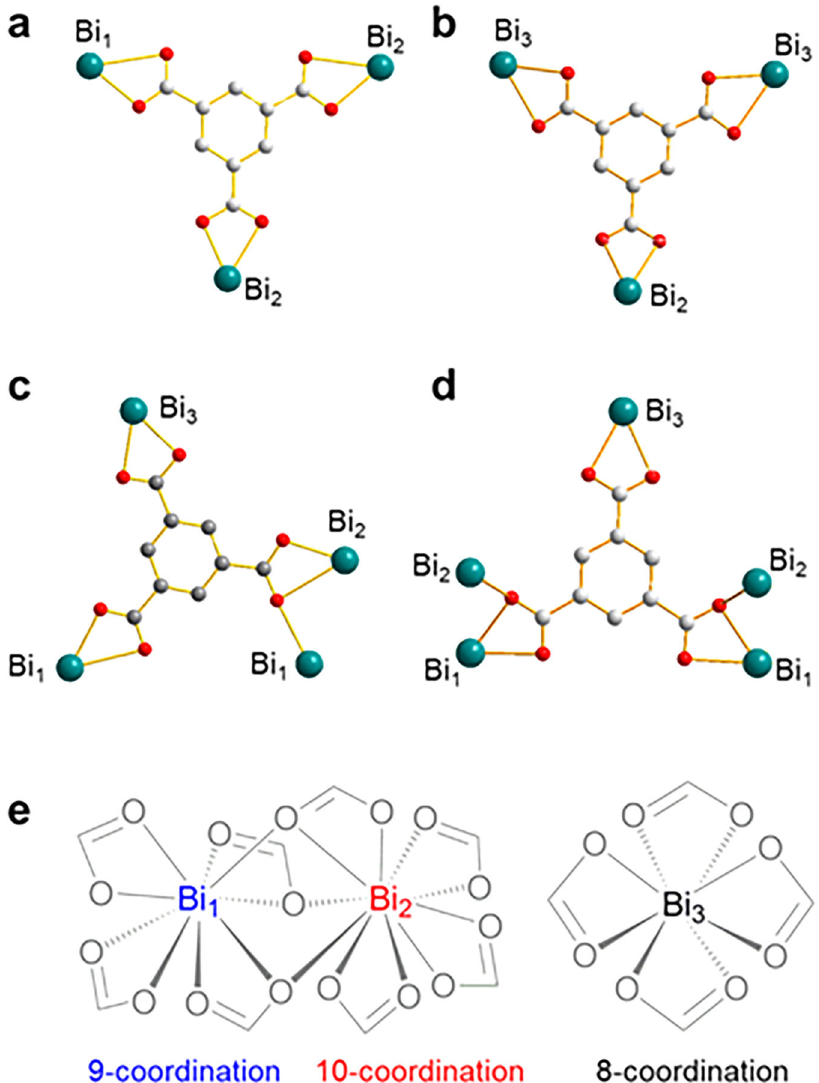
Fig. 3 Coordination mode of Bi-BTC. a – d Coordination geometry of BTC ligand bound to each Bi 3 + center in four different manners. e Three crystallographically independent Bi 3 + metal centers; binuclear {Bi 1 -Bi 2 } centers are bridged by three carboxylate